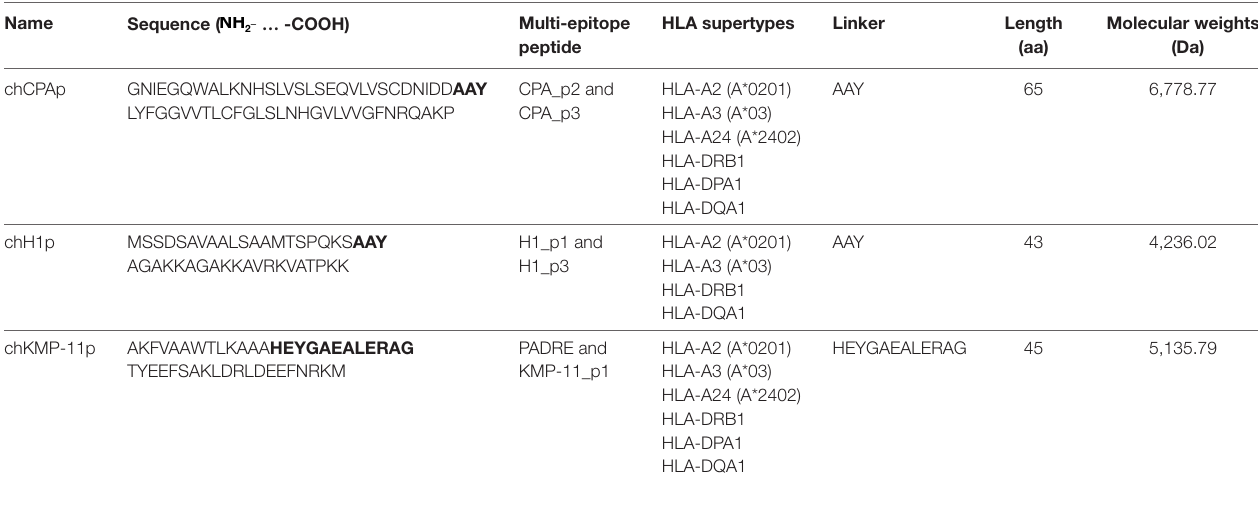
TaBle 1 | Chimeric peptides containing multi-epitope peptides of the Leishmania infantum immunogenic proteins cysteine peptidase A (CPA), histone H1, and kinetoplastid membrane protein 11 (KMP-11).